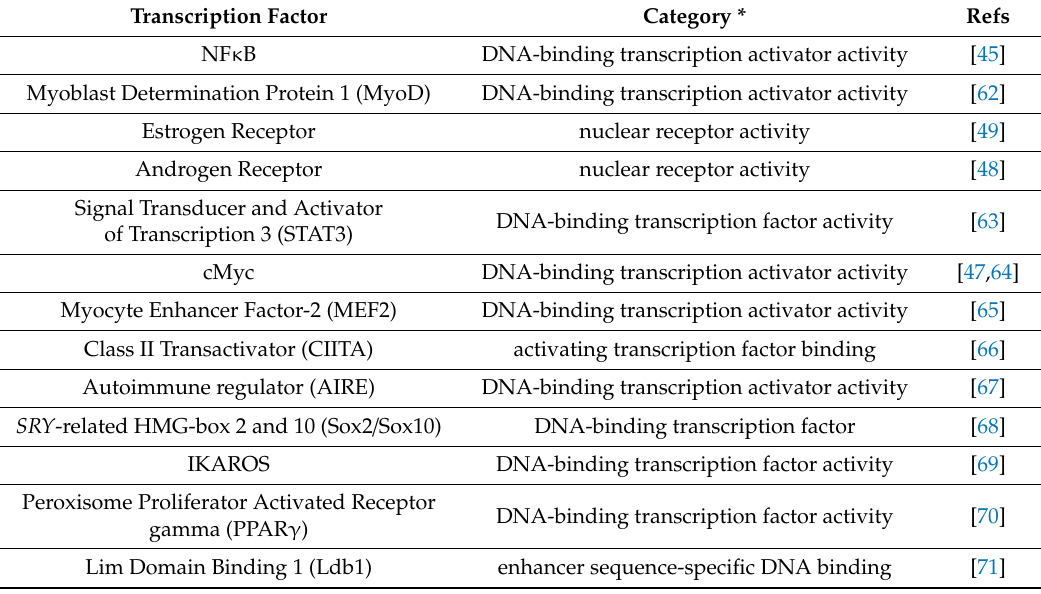
Table 1. Cellular transcription factors that interact with